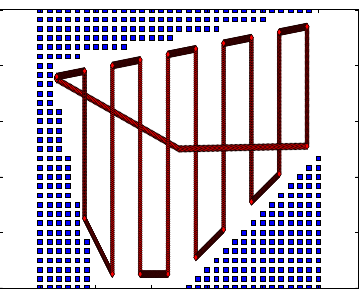
Figure 4. Example generation of rectilinear coverage plan for a region with continuous